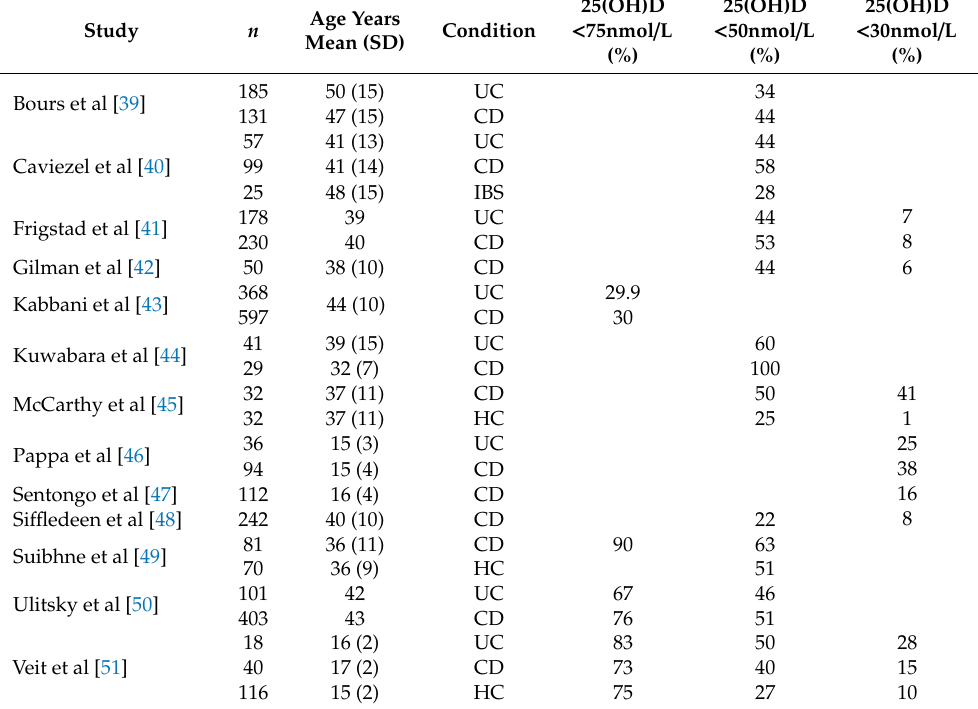
Table 1. Prevalence of vitamin D deficiency and insu ffi ciency in inflammatory bowel disease (IBD) [30]. Age Years Study n Mean